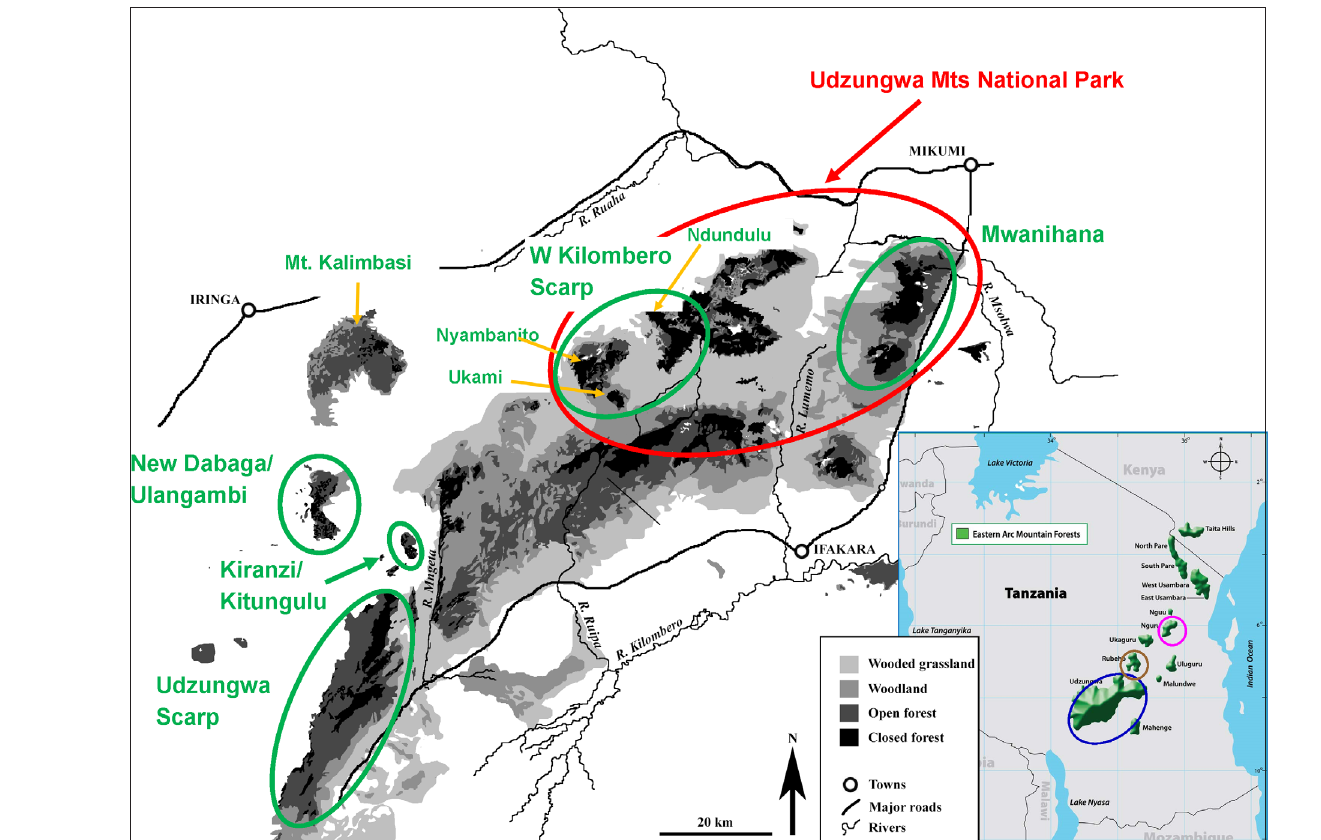
Fig. 2. Map of the Udzungwa Mountains, showing the location of the forest reserves (green ovals), the Udzungwa Mountains National park (red oval) and some individual mountains (yellow arrows) where specimens of Eviulisoma have been collected. Inset: the Eastern Arc Mountains, showing the location of the Udzungwa (blue oval), Rubeho (brown ring) and Kanga (pink ring) Mountains. Based on Marshall et al. (2010: fig. 1); inset by permission of the Eastern Arc Mountains Conservation Endowment